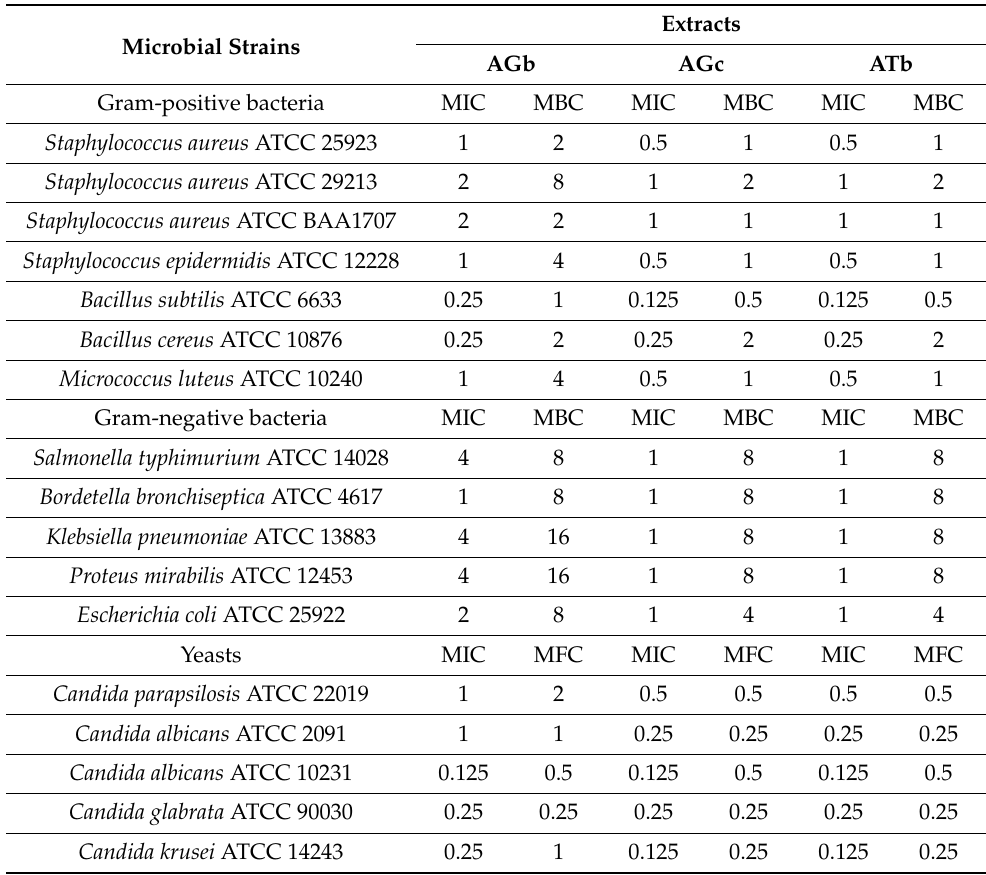
Table 3. MIC (mg/mL) and MBC (mg/mL) and MFC (mg/mL) values of dried ether extracts obtained from two Kazakh species of onions- Allium galanthum and Allium turkestanicum against the reference